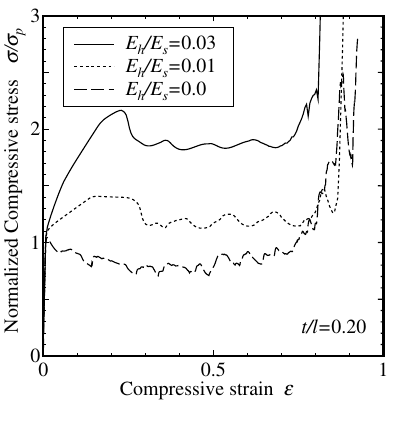
Figure 3. Stress-strain responses of a finite honeycomb with t/l = 0 . 20 .